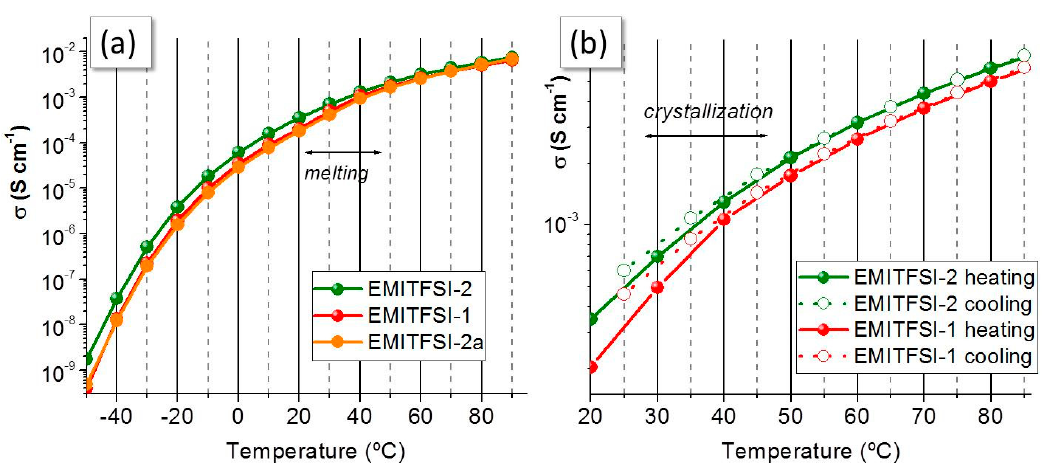
Figure 4. ( a ) σ measured when raising the temperature from − 50 ◦ C to 90 ◦ C (left); ( b ) σ measured on heating from 30 ◦ C to 90 ◦ C (solid symbols) and on cooling from 85 ◦ C to 25 ◦ C (open